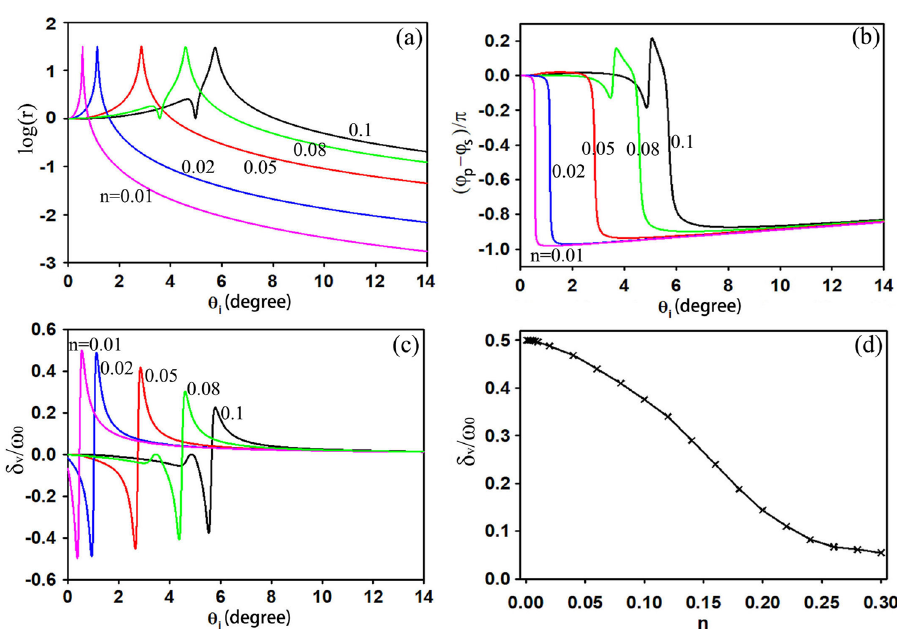
Figure 5. Log(r) (a) , phase difference (b) , and transverse shifts (c) of V-polarized input as functions of incident angle for different refractive indices of the ENZ slab. (d) Maximum transverse shift varying with the refractive index of the ENZ slab. The parameters of the ENZ slab and incident beam are chosen as h = 3λ, n and ω 0 =